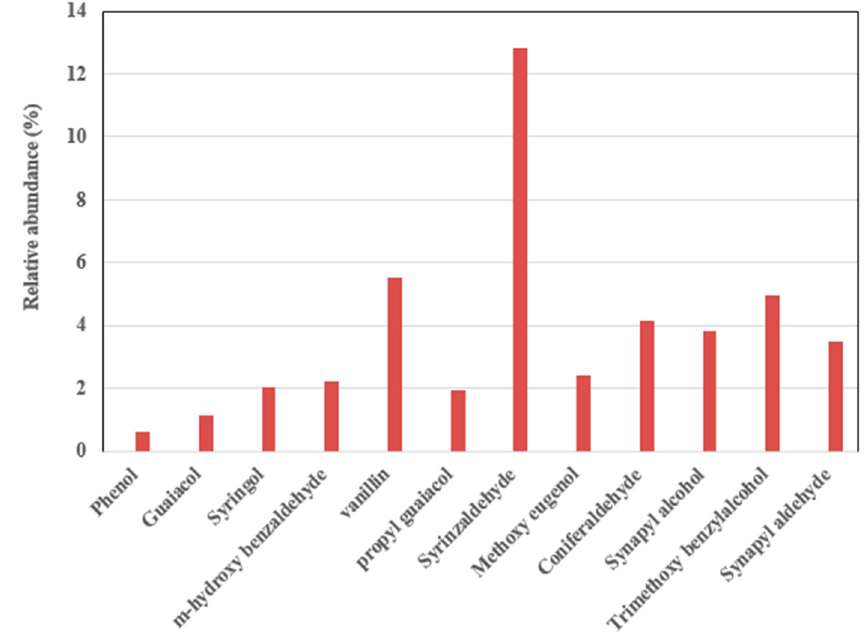
Figure 7. Relative abundance of phenolic monomers from pine sawdust lignin.